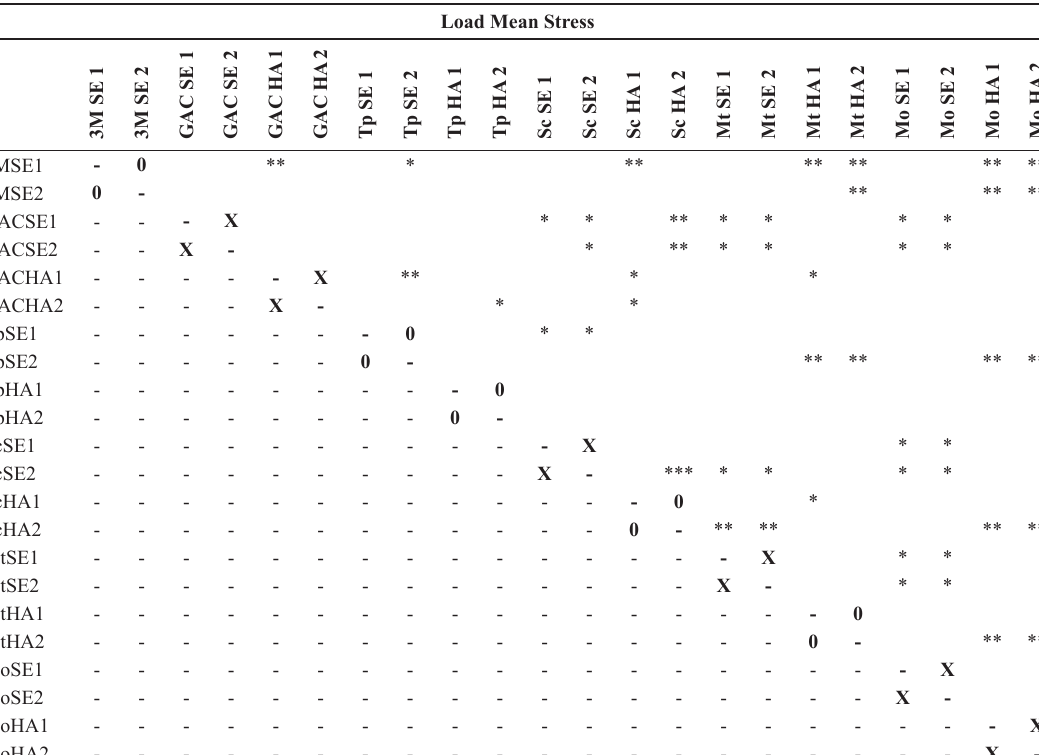
Table 4. Load mean stress comparison among different groups and commercial lots by Tukey test